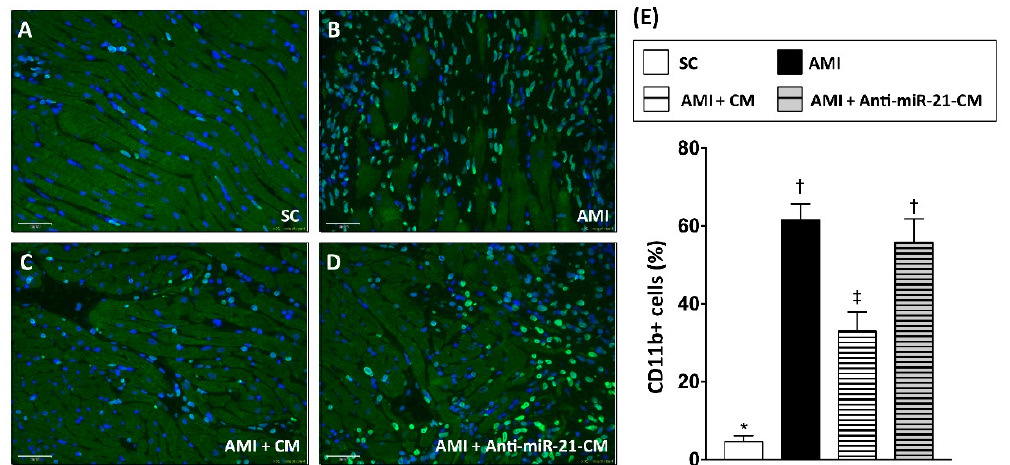
Figure 9. Inhibition of miR-21 reduced the ameliorating effect of conditioned medium on myocardial infiltration of CD11b+ immune cells. ( A ) Immunofluorescent staining to detect the distribution of CD11b+ immune cells in sham control myocardial section. ( B ) Immunofluorescent staining to detect the distribution of CD11b+ cells in myocardial section from rats with AMI induction. ( C ) Immunofluorescent staining to detect the distribution of CD11b+ cells in myocardial section from rats with AMI induction and injection of conditioned medium derived from OGD-treated cardiomyocytes. ( D ) Immunofluorescent staining to detect the distribution of CD11b+ cells in myocardial section from rats with AMI induction and injection of conditioned medium derived from OGD-treated cardiomyocytes with anti-miR-21 pre-transfection. ( E ) Calculation of CD11b+ cells in myocardium. SC, sham control. AMI, acute myocardial infarction. CM, conditioned medium derived from OGD-treated cardiomyocytes. Anti-miR-21-CM, conditioned medium derived from cardiomyocytes pre-transfected with anti-miR-21 (20 nM). Groups with di ff erent symbols (*, †, ‡), p < 0.05. n = 8 for each group. Scale bar in left lower corner indicates 50 μ m.